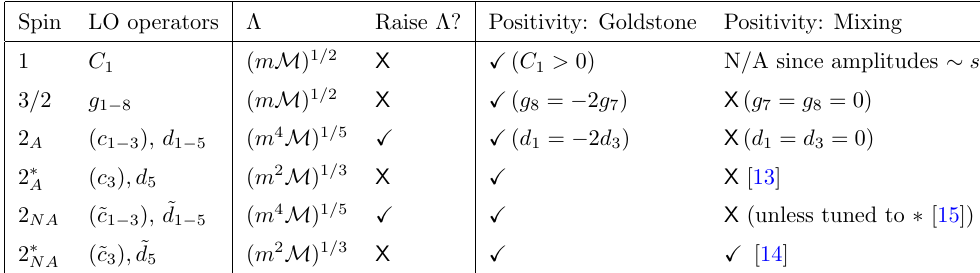
Table 1 . UV implications of massive spinning particles, for spins 1, 3 = 2 and 2. For spin-2 there are two cases, depending on whether it is an Abelian (2 A ) or non-Abelian (2 NA ) gauge symmetry which is softly broken by the mass terms. The leading order quartic (and cubic) unitarity gauge potential, m 2 (cid:0) (cid:18) M 2+ (cid:18) V , contains the Wilson coe(cid:14)cients given in the second column. The strong coupling scale can be established o(cid:11)-shell at the level of the Lagrangian, and only for spin-2 can it be raised by an O (1) tuning of the Wilson coe(cid:14)cients (in terms of, e.g., c 3 and d 5 ), leading to theories with a particular WZ structure (2 (cid:3) ). In all cases, the purely longitudinal (Goldstone) sector can satisfy positivity bounds for some region of parameter space, but spin-1 is the only Abelian theory whose mixing between longitudinal and transverse modes is also consistent with positivity (we implicitly refer only to those operators that contribute to the on-shell 2-to-2 scattering amplitude at tree- level). For the non-Abelian spin-2, it is the particular two-derivative terms (comparable to the zero-derivative potential) which allow for all known positivity bounds to be